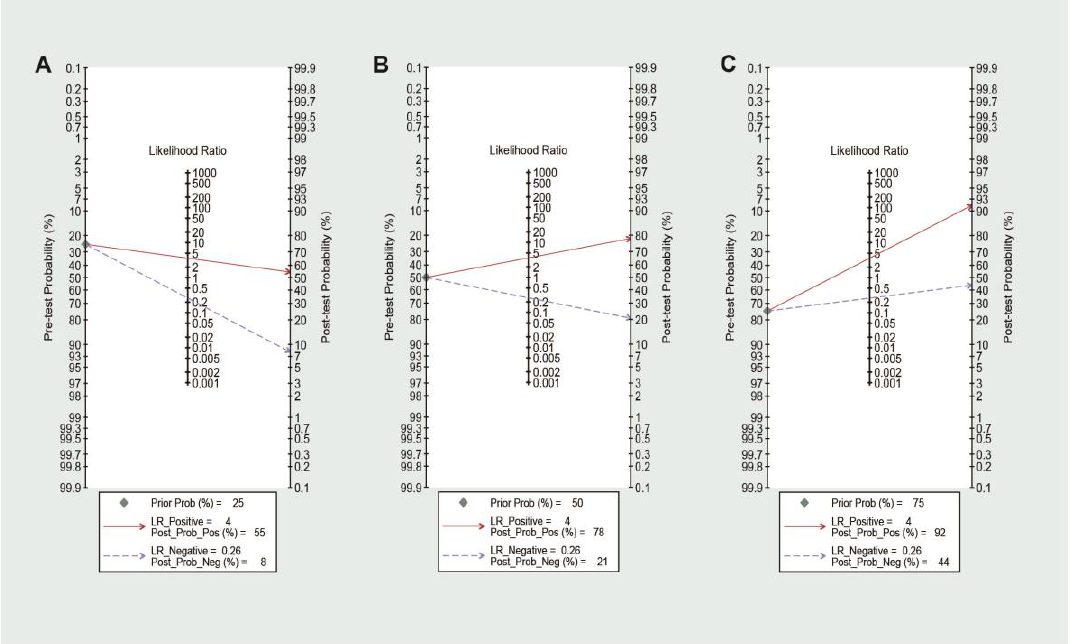
Figure 4. Fagan nomogram analysis evaluating the clinical utility of FC for predicting IBD relapse according to different pretest probabilities (prior). ( A ) Pretest probability = 25%; ( B ) pretest probability = 50%; and ( C ) pretest probability = 75%.